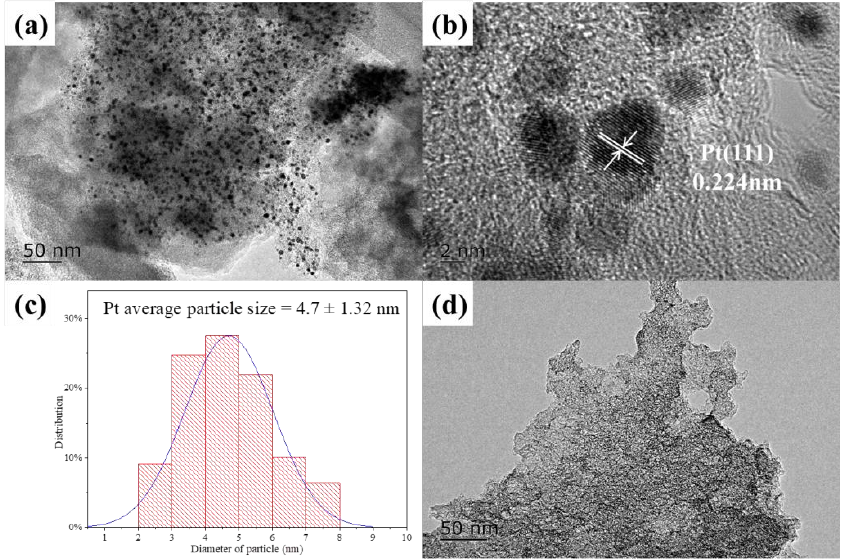
Figure 3. TEM images of 0.5% Pt/AC ( a , b ), 2% FeO x /AC ( d ), and particle size distribution histo- gram of 0.5% Pt/AC ( c ).